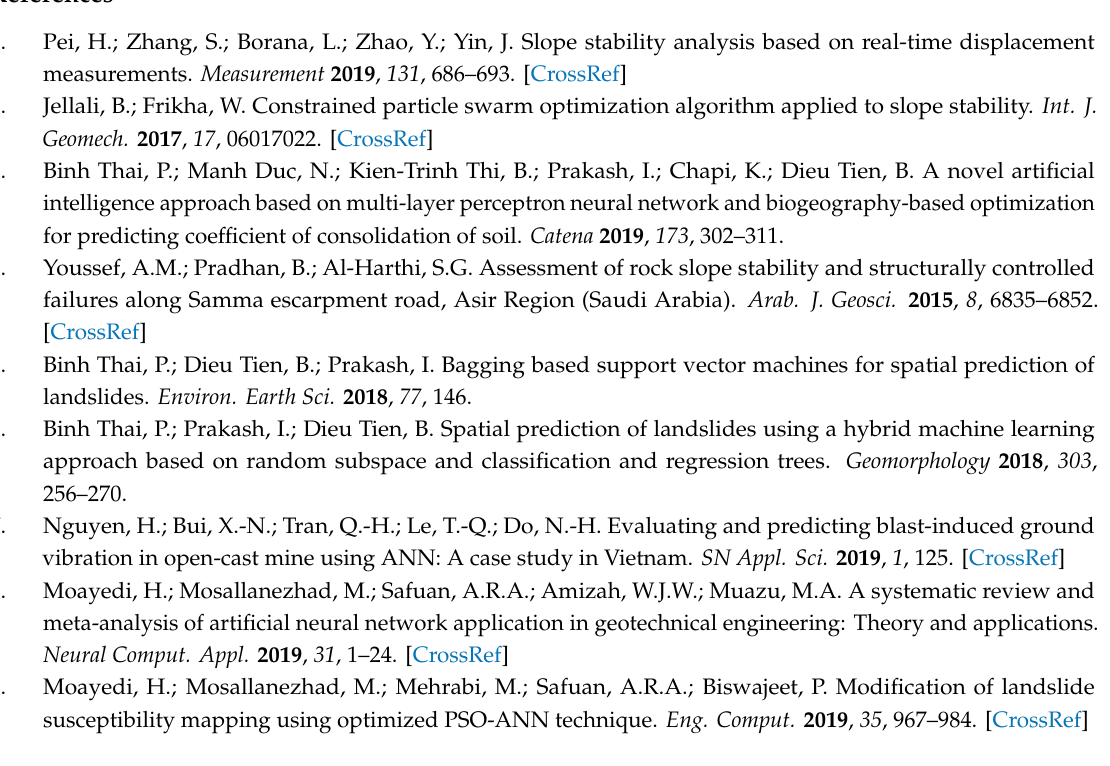
Figure S1: PSO-ANN solution charts for the β = 30 ◦ . Figure S2: PSO-ANN solution charts for the β = 45 ◦ . Figure S3: PSO-ANN solution charts for the β = 60 ◦ . Figure S4: PSO-ANN solution charts for the β = 75 ◦ . Author Contributions: D.T.B. and H.M. performed the experiments and field data collection. H.M., B.K. and M.G. wrote the manuscript, and discussed and analyzed the data. B.P. and A.J. edited, restructured, and